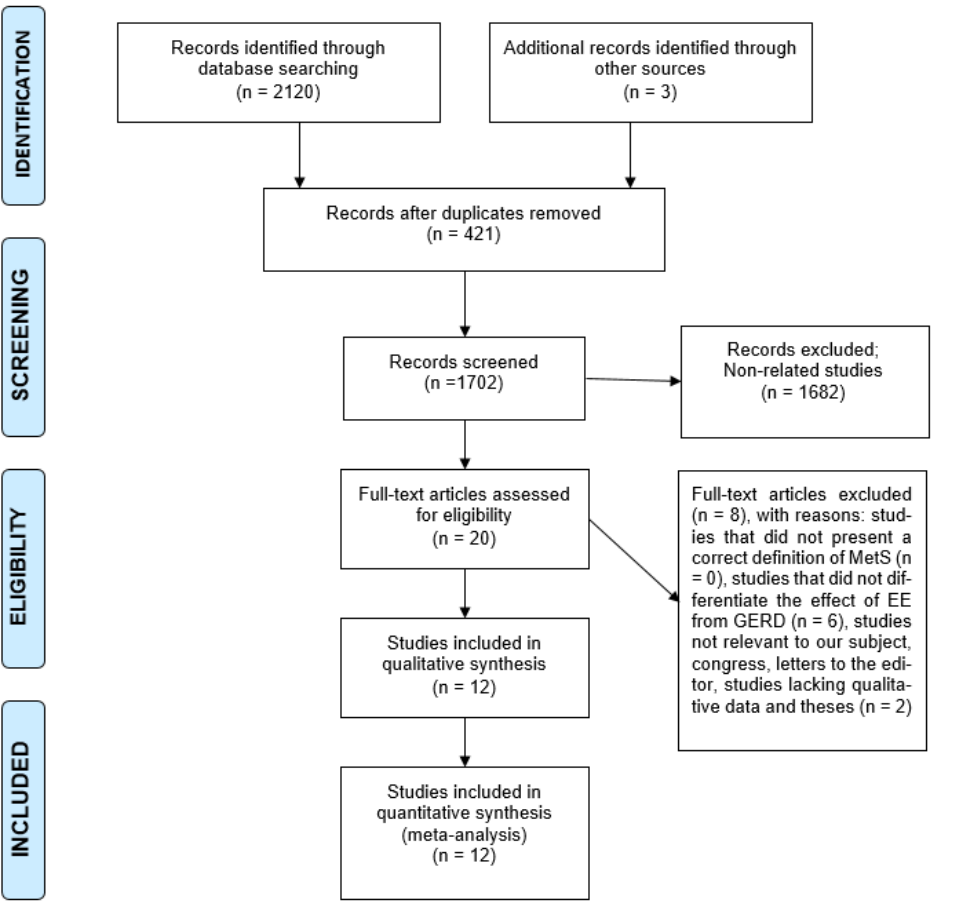
Figure 1: The studies selection process for